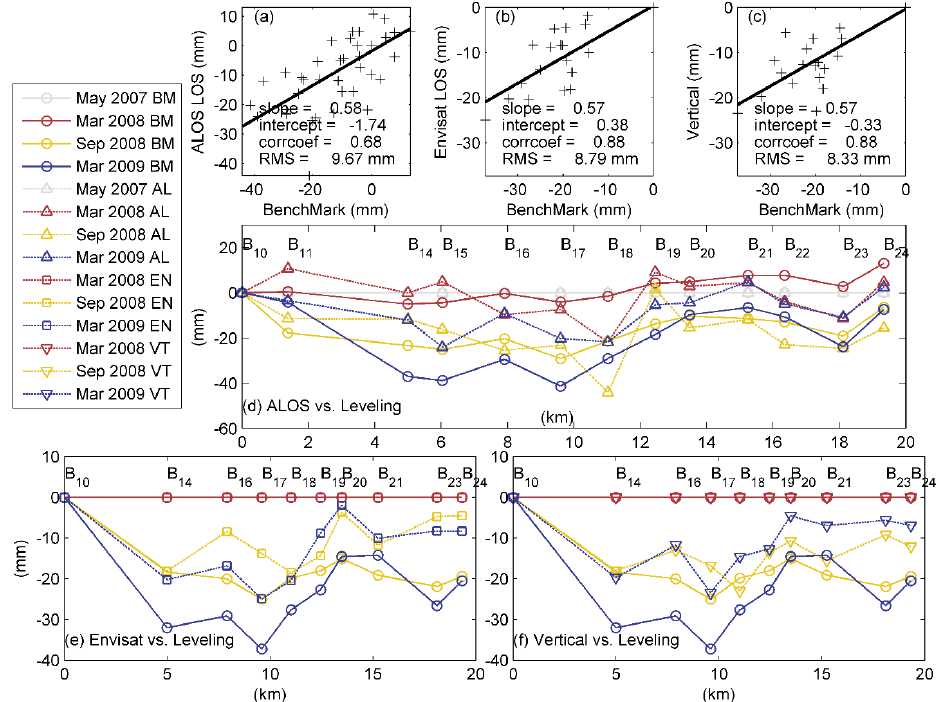
Figure 4. ( a ) Correlation between ALOS LOS displacements and four leveling campaigns; ( b ) correlation between Envisat LOS displacements and three leveling campaigns; ( c ) correlation between decomposed vertical displacements and three leveling campaigns; ( d ) interpolated ALOS displacements and leveling displacement; ( e ) interpolated Envisat displacements and leveling displacement; and ( f ) decomposed vertical displacement and leveling displacement.